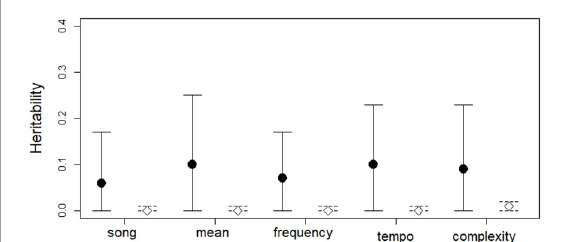
FIGURE2 Heritability estimates with 95% credible intervals for the song traits. Solid line and solid black points represent estimates based on genetic similarity and empty diamonds and dashed lines represent results from the models using randomized response variables (N of individuals = 81, except for complexity, for which N of individuals =